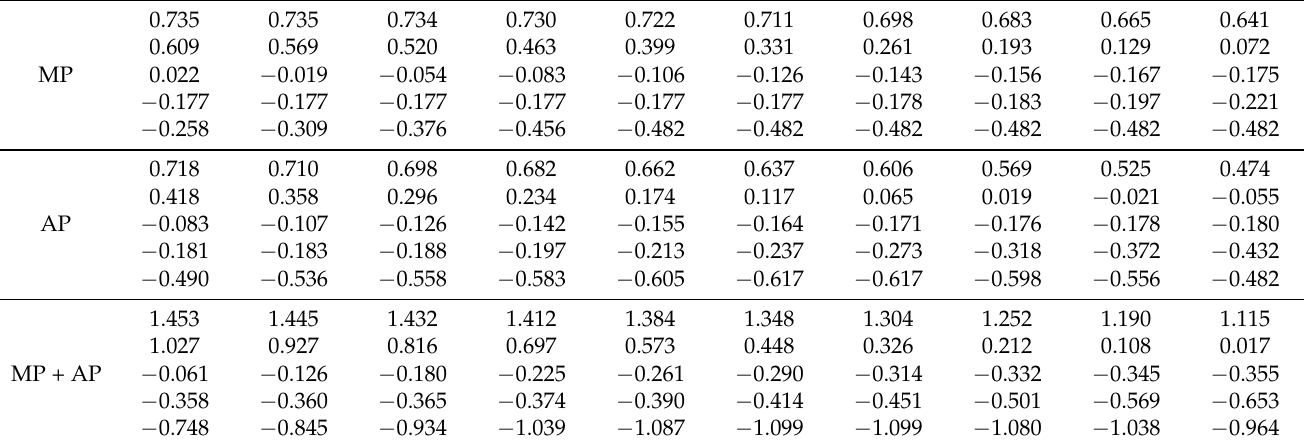
Table 4. Calculation results of the three